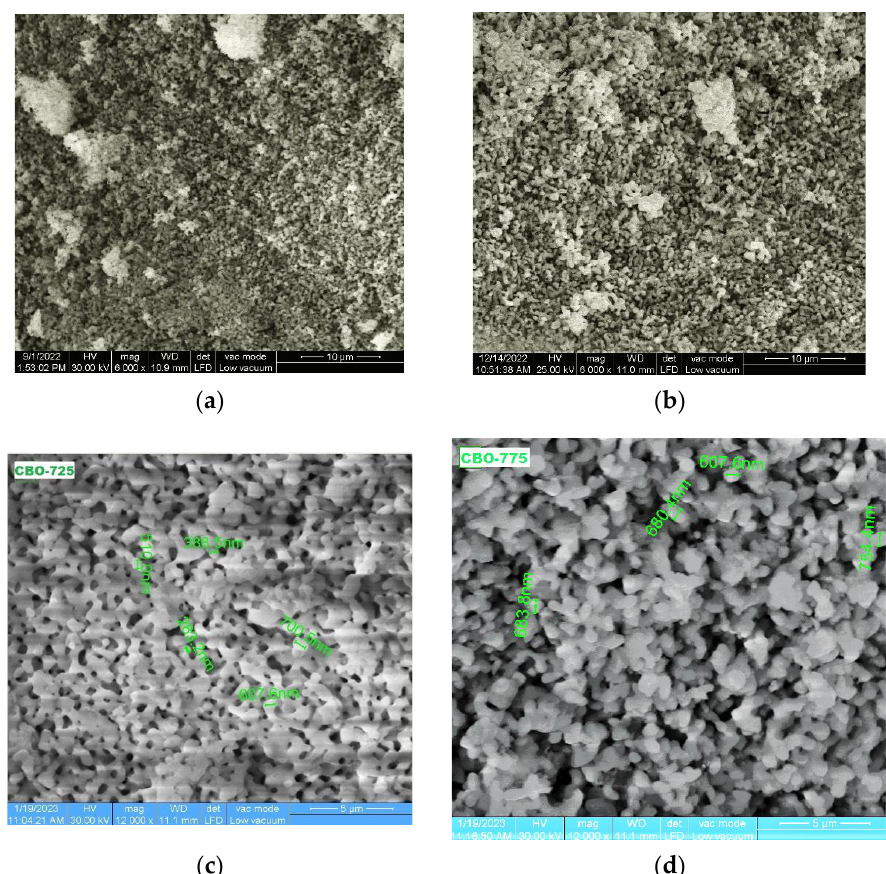
Figure 6. SEM pictures recorded for ( a ) CBO-600 at 10 µm, ( b ) CBO-725 at 10 µm, ( c ) CBO-725 at 5 µm, and ( d ) CBO-775 at 5 µm.